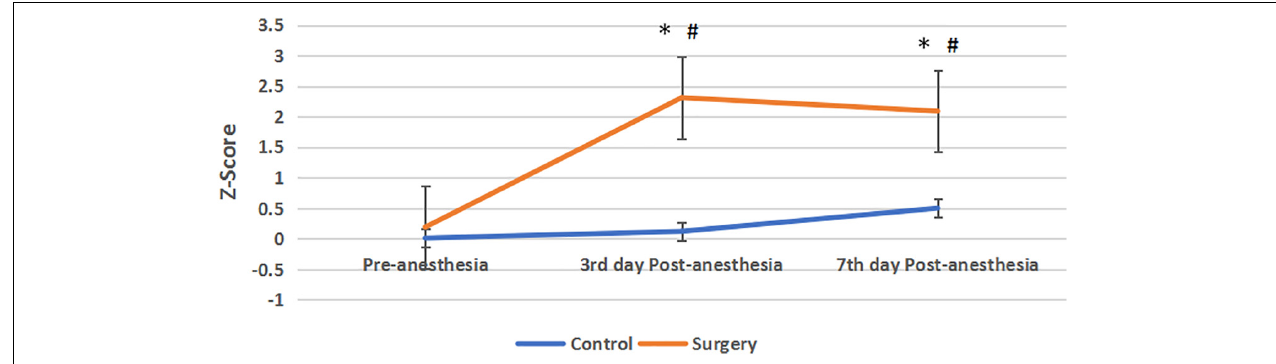
FIGURE 3 | Z -score between the two groups. Compared with pre-anesthesia, the Z -scores of patients in the surgical group were significantly increased at the 3rd and 7th day Post-anesthesia, Z -score > 1.96 indicate the cognitive function was impaired. Compared with the control group, the Z -scores in the surgical group were increased and their cognitive function was impaired, and the difference between the two groups was statistically significant. Values are mean ± SEM. N = 30,* p < 0.05 vs. the control group; # p < 0.05 vs. pre-anesthesia.